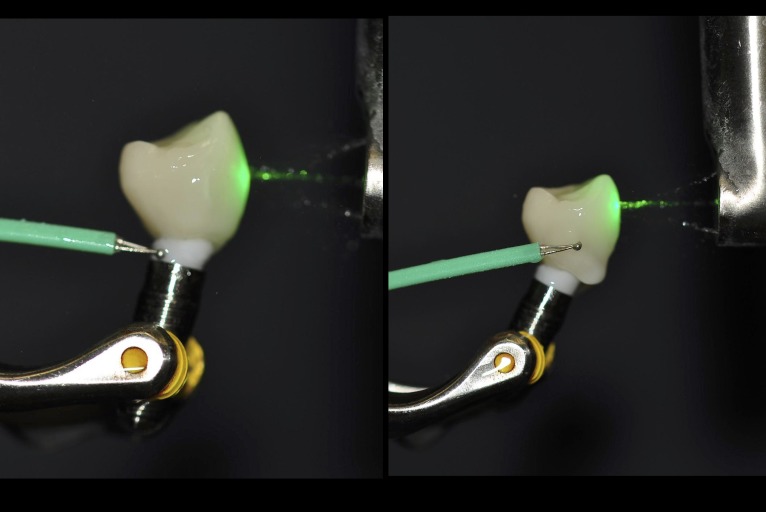
Temperature measurements of crown and abutment during laser irradiation.